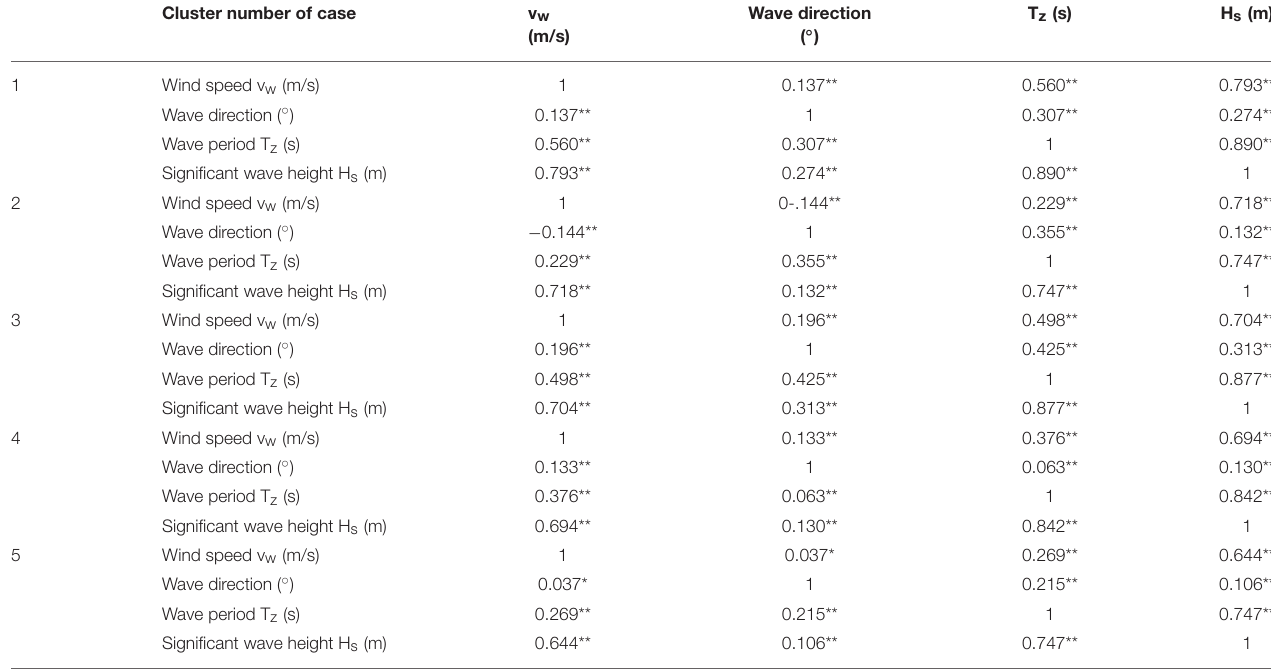
TABLE 5 | Correlation analysis between wind and wave. Cluster number of case